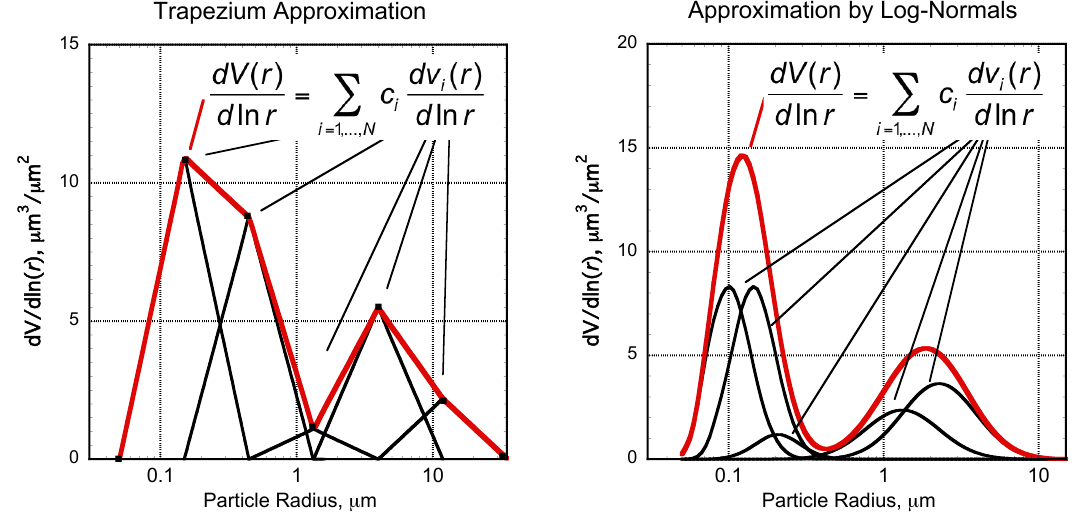
Fig. 4. The illustration of modeling aerosol size distribution by five ( N r =5) triangular (left) or log-normal (right) size bins.